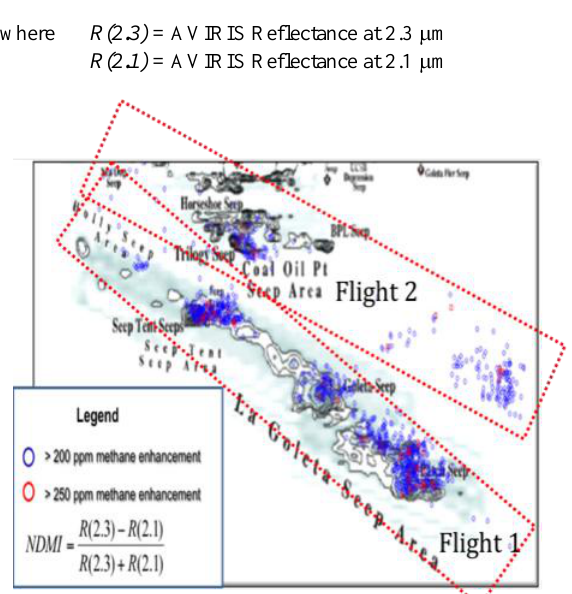
Figure 1. ASPECT Methane detection results, using a Normalized Differential Methane Index to identify regions of high methane content, these points correlated to known seep locations off of Santa Barbara, CA.